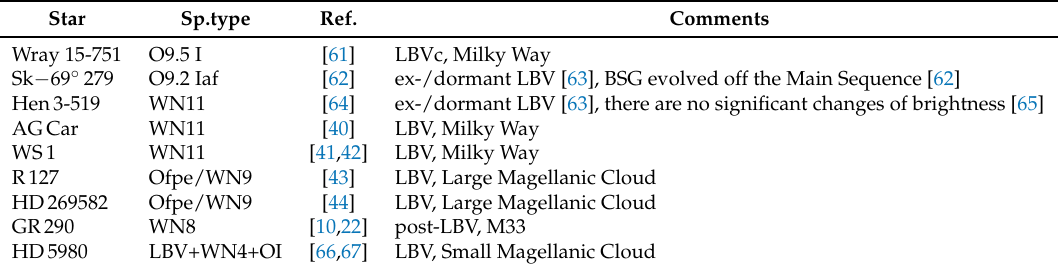
Table 6. Comparison of Romano’s star with other LBVs and LBV candidates which show WR like